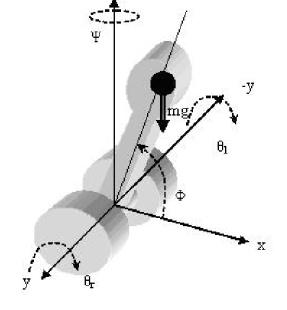
Fig. 1. WIP System